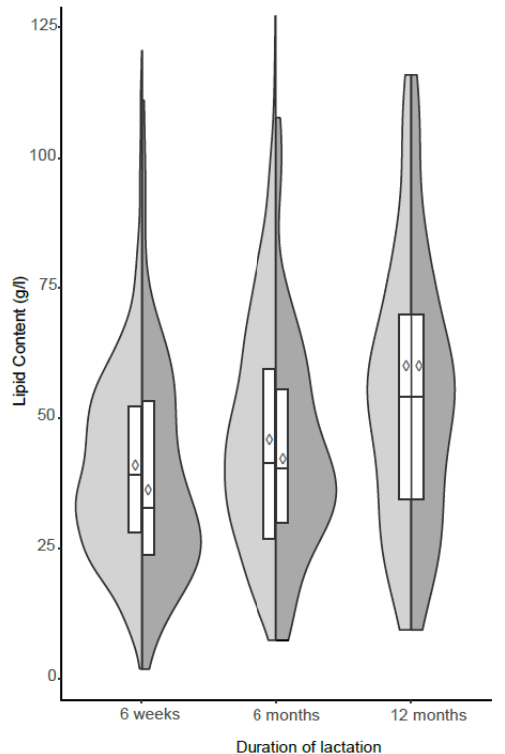
Figure 1. Distribution of total lipid content concentrations (g / L) of human milk samples at 6 weeks, 6 months, and 12 months of lactation. Shaded areas show split violin plots of the density function with inserted boxes indicating the first and third quartile and the median and with inserted ♦ indicating the arithmetic mean. ♦ Arithmetic mean lipid content of given sample si Total sample size (6 weeks ( n = 706), 6 months ( n = 483), 12 months ( n = 81)), Sub-sampl e size ( n = 81). Table 2. Means and standard deviations of centered log ratio (clr)-transformed fatty acid concentrations of human milk samples measured at 6 weeks, 6 months, and 12 months of lactation ( n = 81).